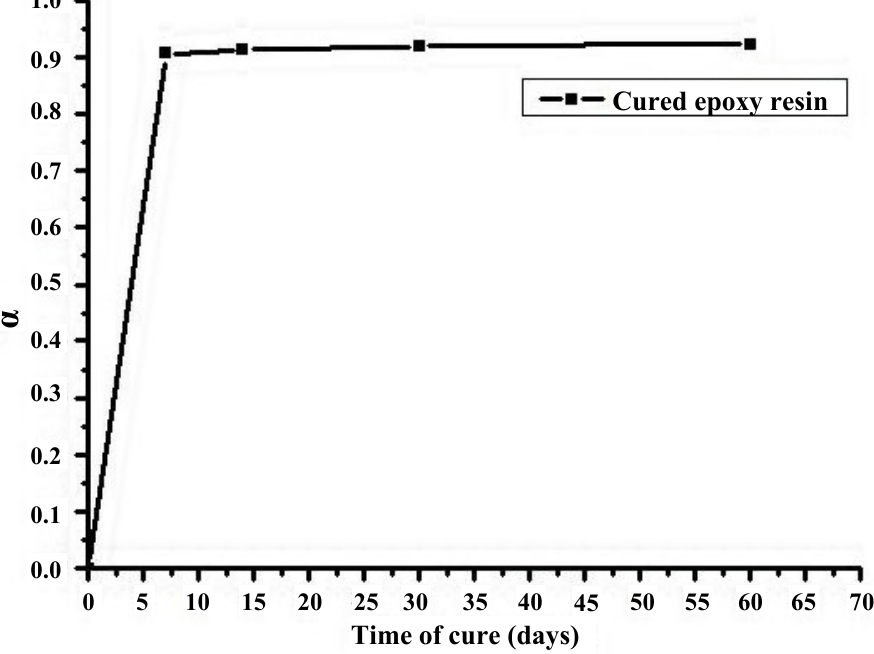
Figure 2. Extent of cross-linking reactions for the cold-cured epoxy resin as a function of the curing